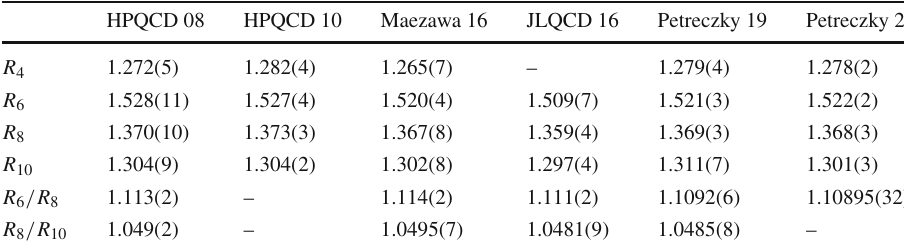
ratios of the moments from N f = 3 simulations at the charm